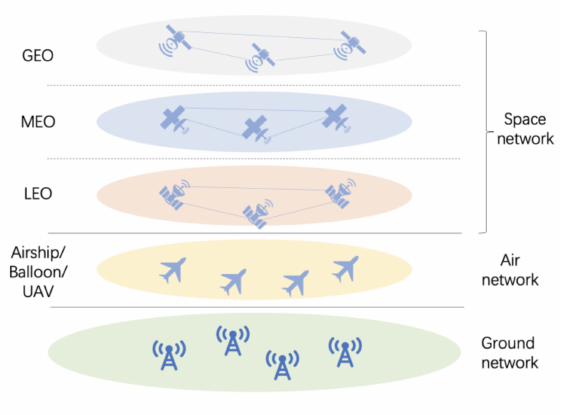
Figure 1. An architecture for a space–air–ground integrated